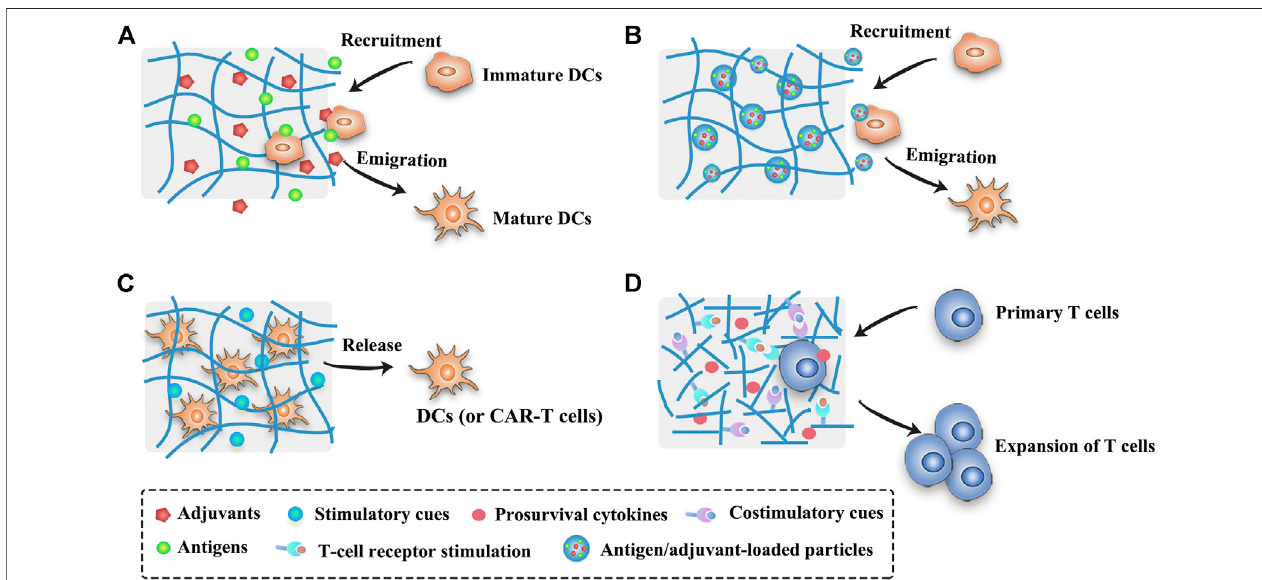
FIGURE 3 | Schematic illustration of strategies of scaffold- or hydrogel-based cancer vaccines. (A) Scaffold- or hydrogel-based cancer vaccines can recruit immature DCs into the injection site and subsequently activate them into mature DCs. (B) Nanocomposite hydrogel/scaffold systems can co-deliver antigens and adjuvants into the same DCs. (C) Scaffold- or hydrogel-based adoptive cell transfer can release mature DCs or CAR-T cells in a sustained manner and maintain the viability of cells. (D) Functionalized scaffolds can mimic APCs to directly expand primary T cells.